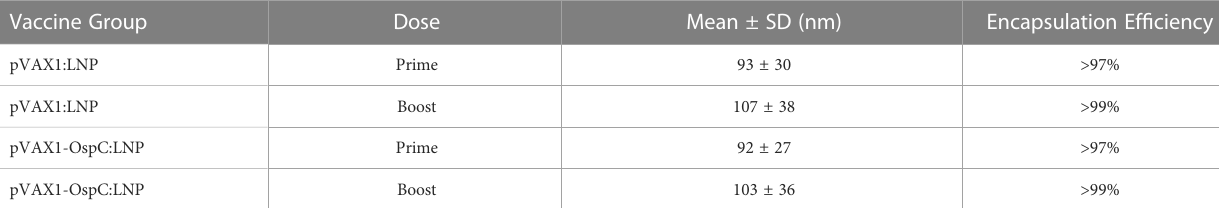
TABLE 1 Characterization of DNA-LNP vaccine formulations. Vaccine